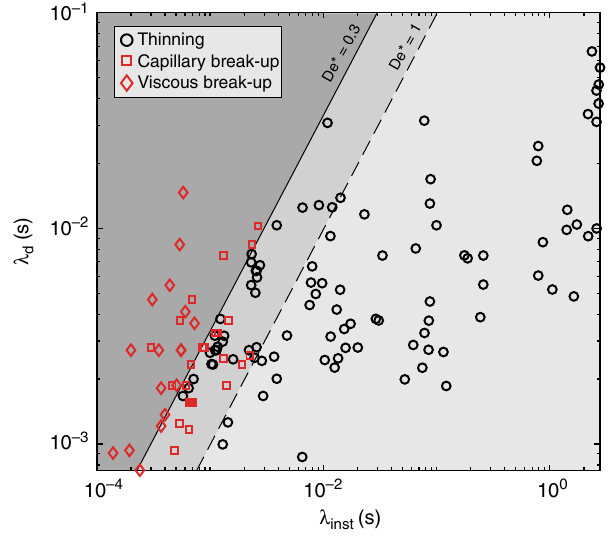
Fig. 3 A behaviour map for the fl uid dynamic break-up of low-viscosity liquids under extension. All experiments are plotted and colour coded for thinning (black) and break-up (red). The style of break-up is denoted by the symbol type, where the squares and diamonds correspond to capillary and viscous break-up, respectively. For modi fi ed Deborah numbers (De*) >1, only thinning is observed, at De* <1 break-up is possible and at De* <0.3, only break-up is